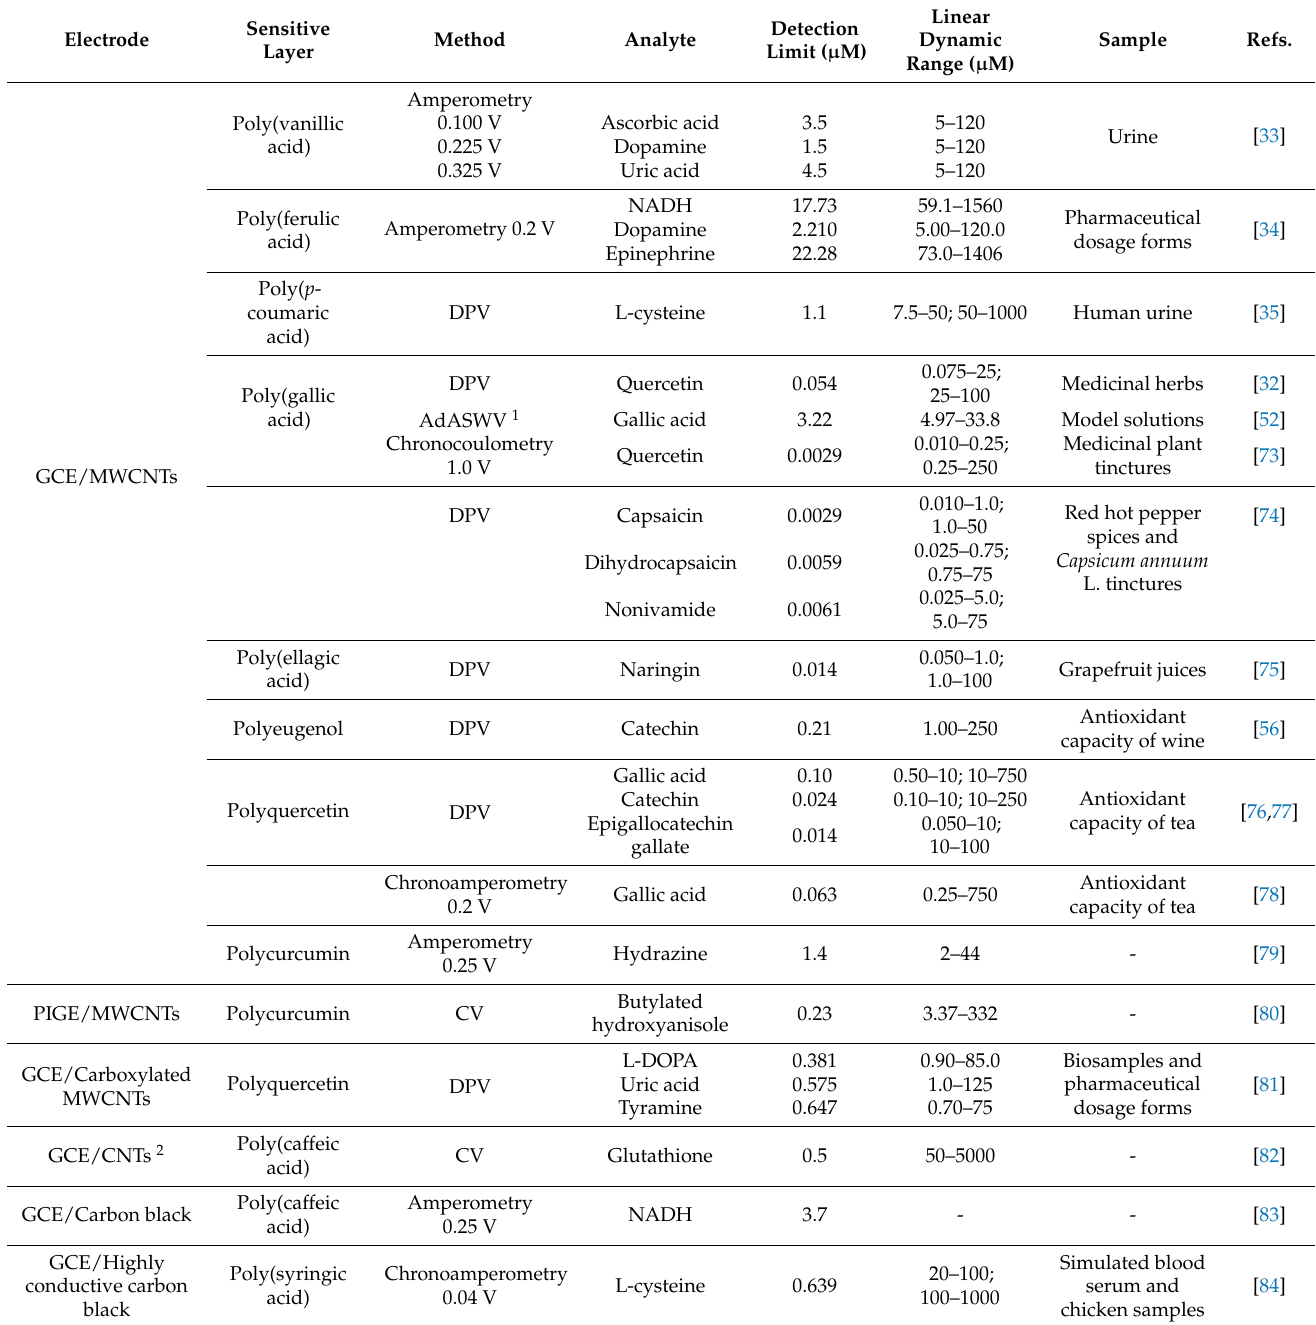
Table 3. Analytical capabilities of the sensors based on the carbon nanomaterials and electropolymerized phenolic